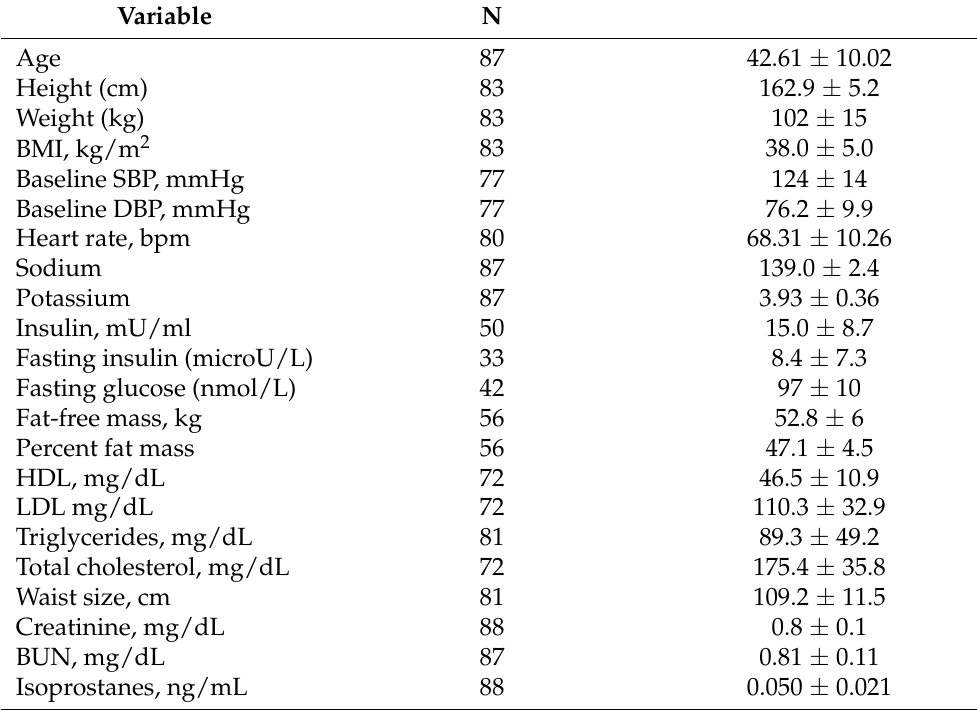
Table 1. Demographic characteristics of